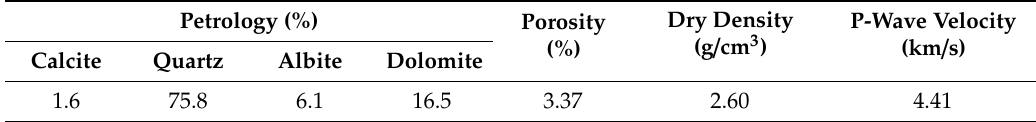
Table 1. Mineral composition and physical properties of the